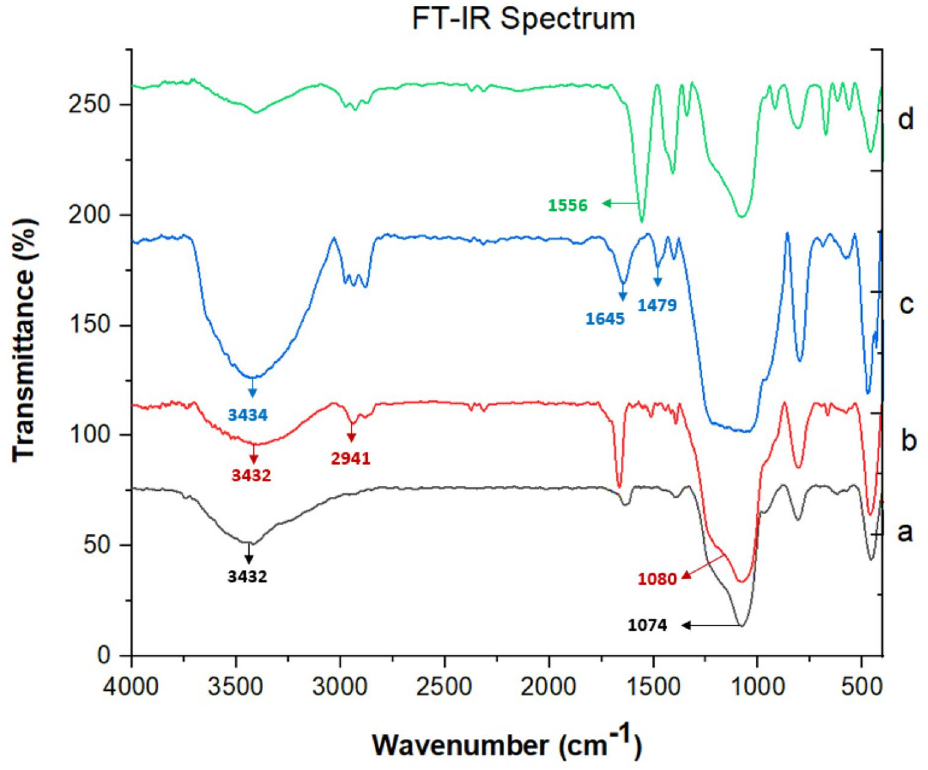
Figure 2. FT-IR spectra of a) MCM-41, b) MCM-41-EPTMS, c) MCM-41-HPr-Met, d) Cu@MCM-41-HPr-